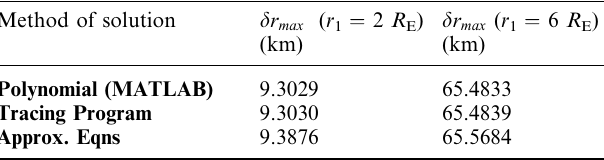
Table 4. Comparison between various numerical estimates for (cid:100) r max at the geomagnetic equator in the general axisymmetric case n max = 10 Method of